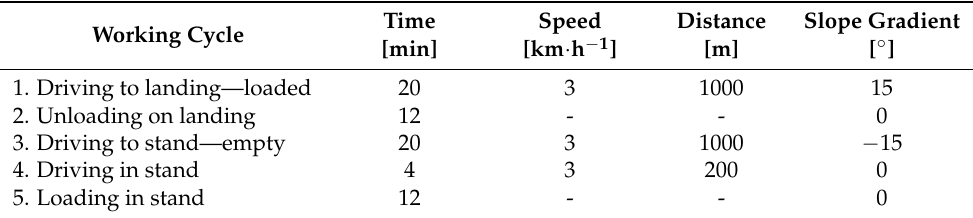
Table 1. Working cycles of the tractor-trailer unit travelling on an unpaved surface.